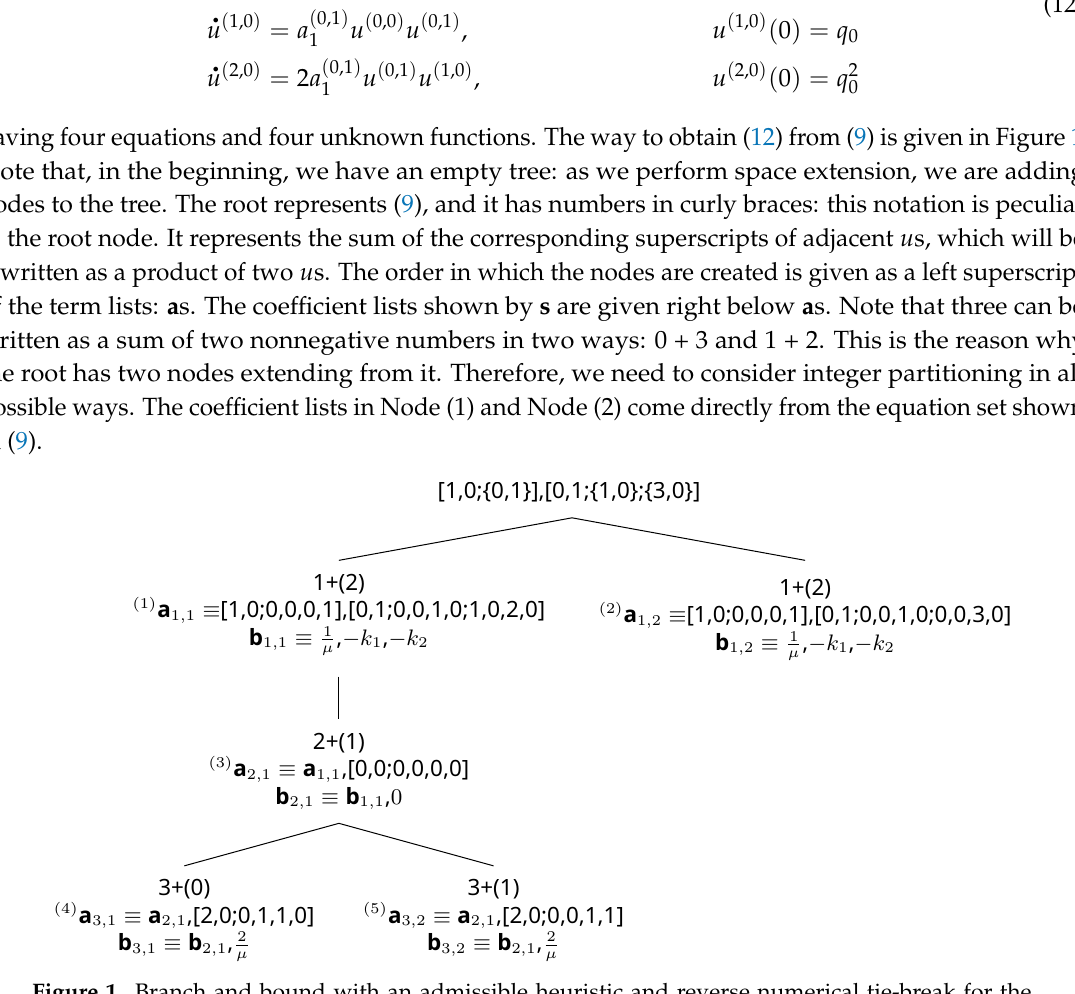
Figure 1. Branch and bound with an admissible heuristic and reverse numerical tie-break for the classical quartic anharmonic oscillator ODE